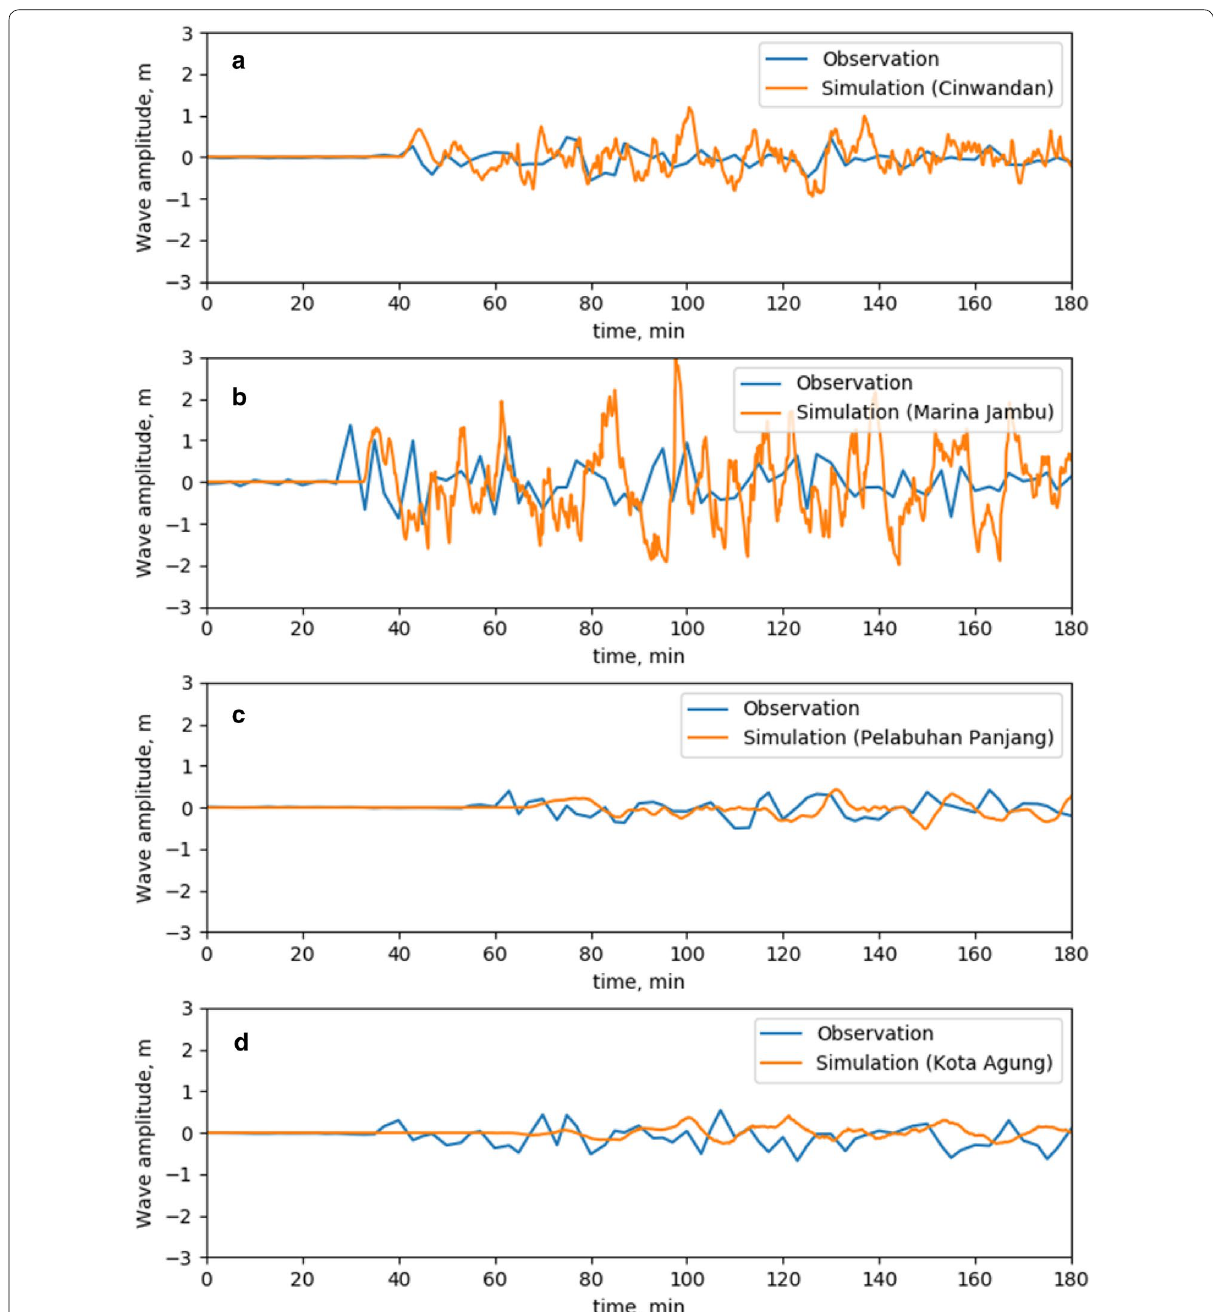
Fig. 11 Comparison between the observation and simulation results at a Ciwandan, b Marina Jambu, c Panjang, and d Kota